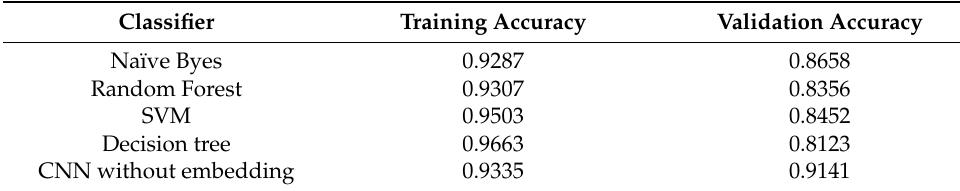
Table 6. Training and validation accuracies between models.